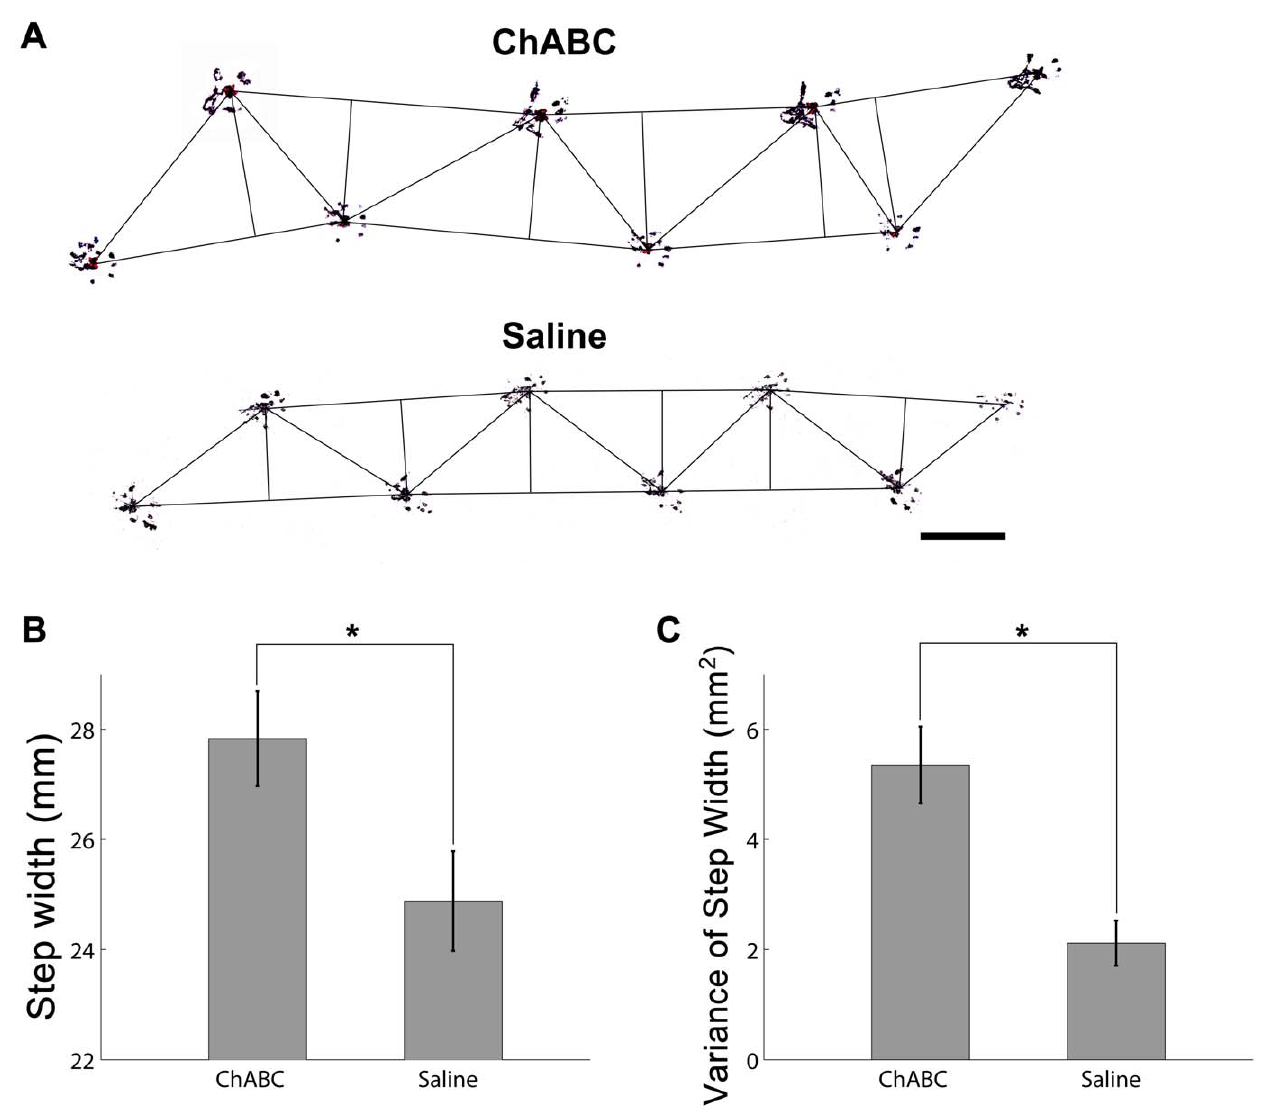
Figure 3. Striatal ChABC treatment significantly increases step width and variance in adult mice. Sample pawprints from ChABC (top) and vehicle (bottom) treated mice (A; see Methods for measurement details). Scale bar: 20 mm. (B) Bar graph showing mean 6 standard error of step width for mice receiving either ChABC (ChABC) or vehicle (Saline) injections in bilateral striatum. Enzyme treated animals exhibited significantly increased hind limb gait widths relative to saline controls (Wilcoxon rank sum test; P =0.0276). *: P , 0.05. (C) Variance, the variability in measured step width for a given subject, was also significantly greater in ChABC treated subjects (Wilcoxon rank sum test; P =0.003). *: P , 0.05.